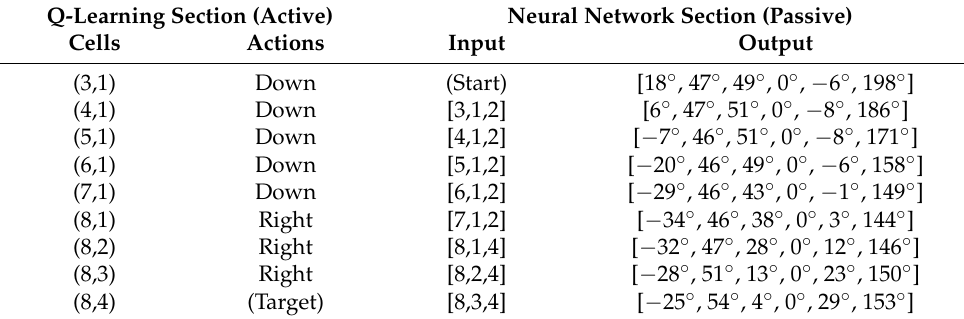
Table 2. Summary of findings.